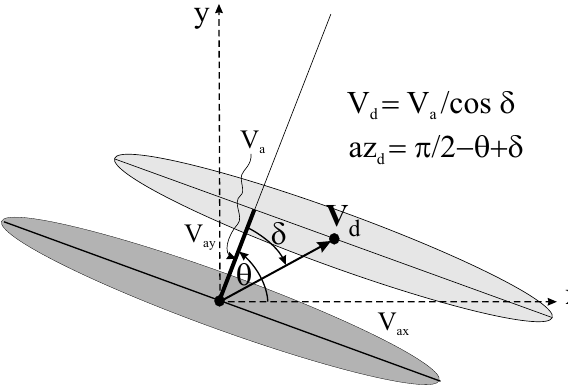
Fig. 9. The same as Fig. 8 but for all events and patches when the standard deviation in average azimuth (both for longest and shortest dimensions) was below 30 ◦ . The points are colour-coded in ab- sorption intensity. The colour bar is shown in the top left corner of panel (a) .